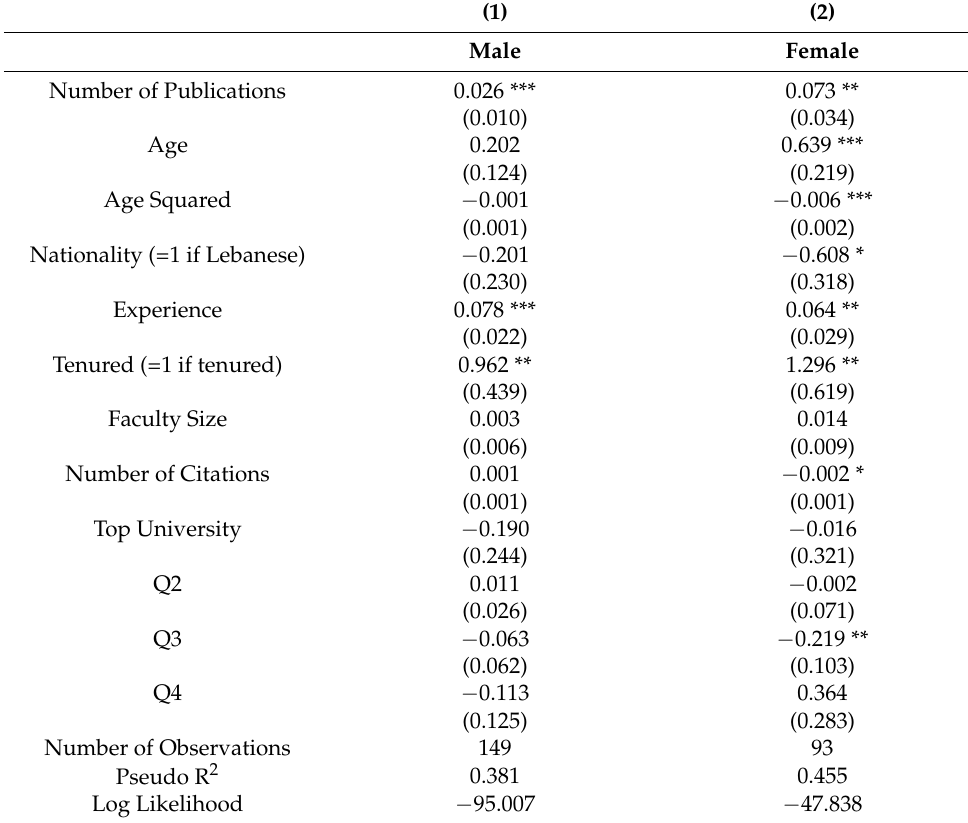
Table 5. Results of the Ordered Probit model, results by